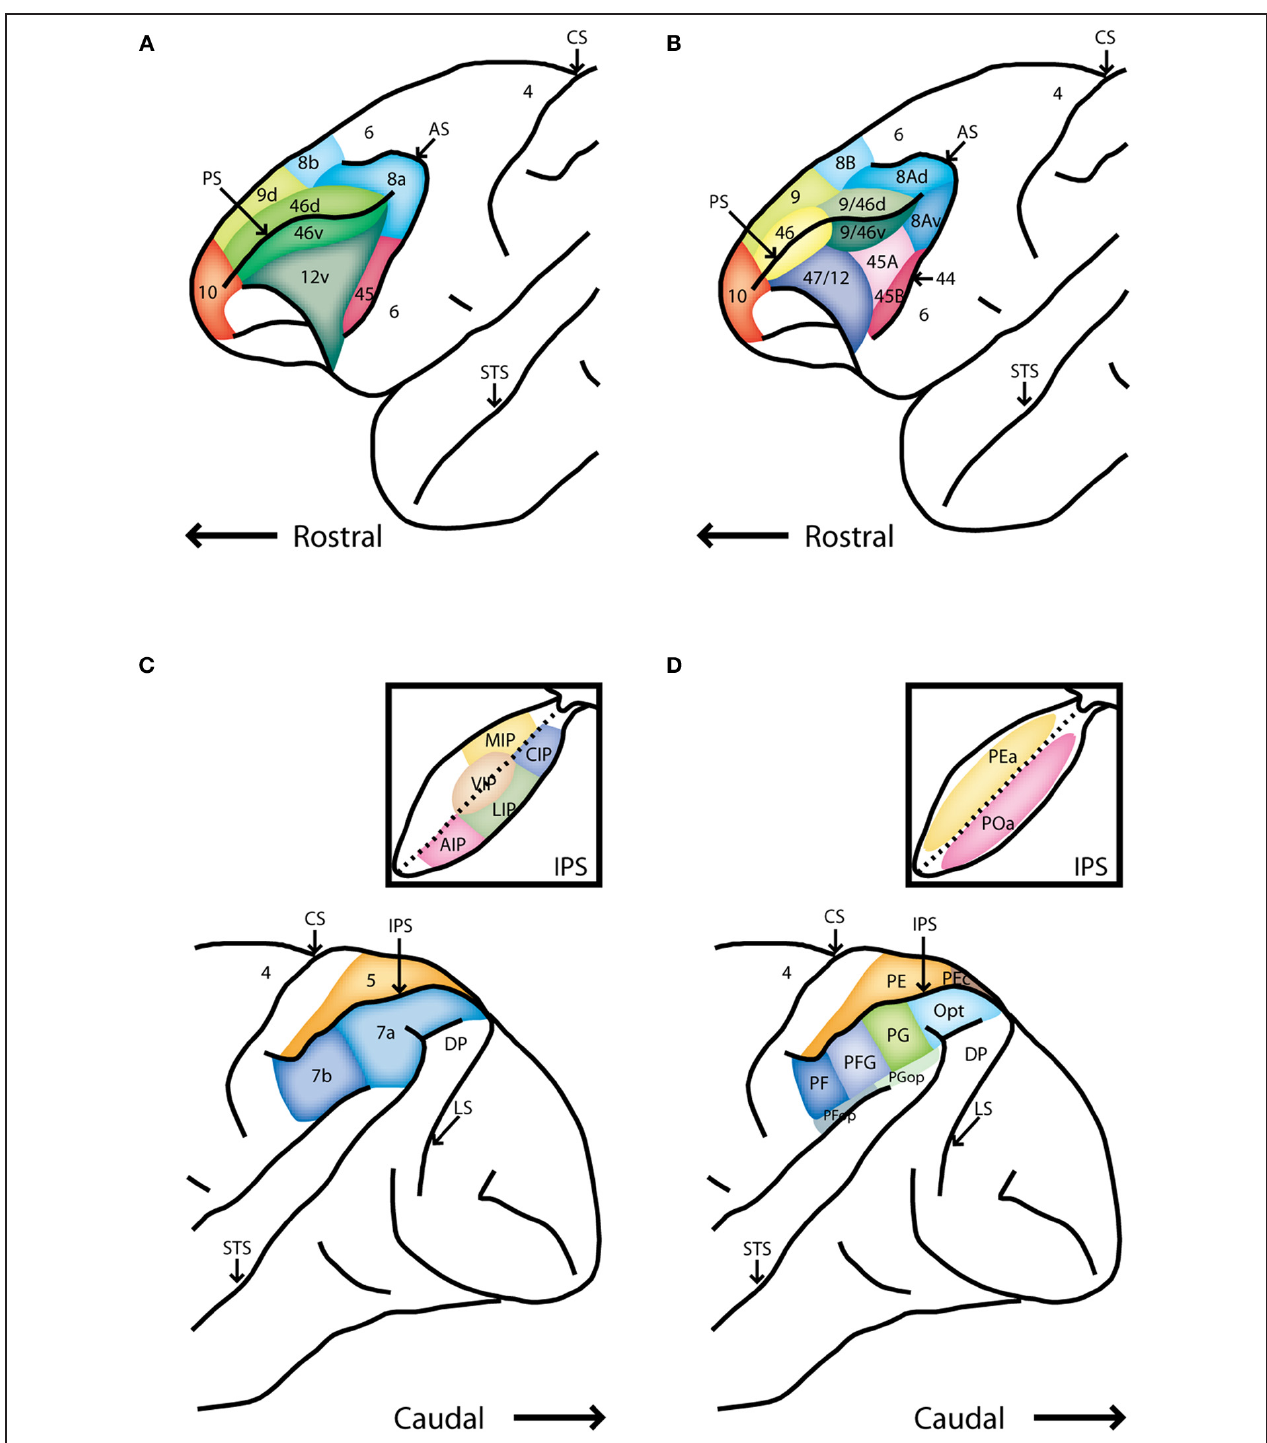
(D) Map of the posterior parietal cortex based on Pandya and Seltzer [Pandya and Seltzer (1982)]. Abbreviations: AIP, anterior intraparietal area; AS, arcuate sulcus; CIP, caudal intraparietal area; CS, central sulcus; DP, dorsal prelunate area; IPS, intraparietal sulcus; LIP, lateral intraparietal area; LS, lunate sulcus; MIP, medial intraparietal area; PS, principle sulcus; STS, superior temporal sulcus; VIP, ventral intraparietal